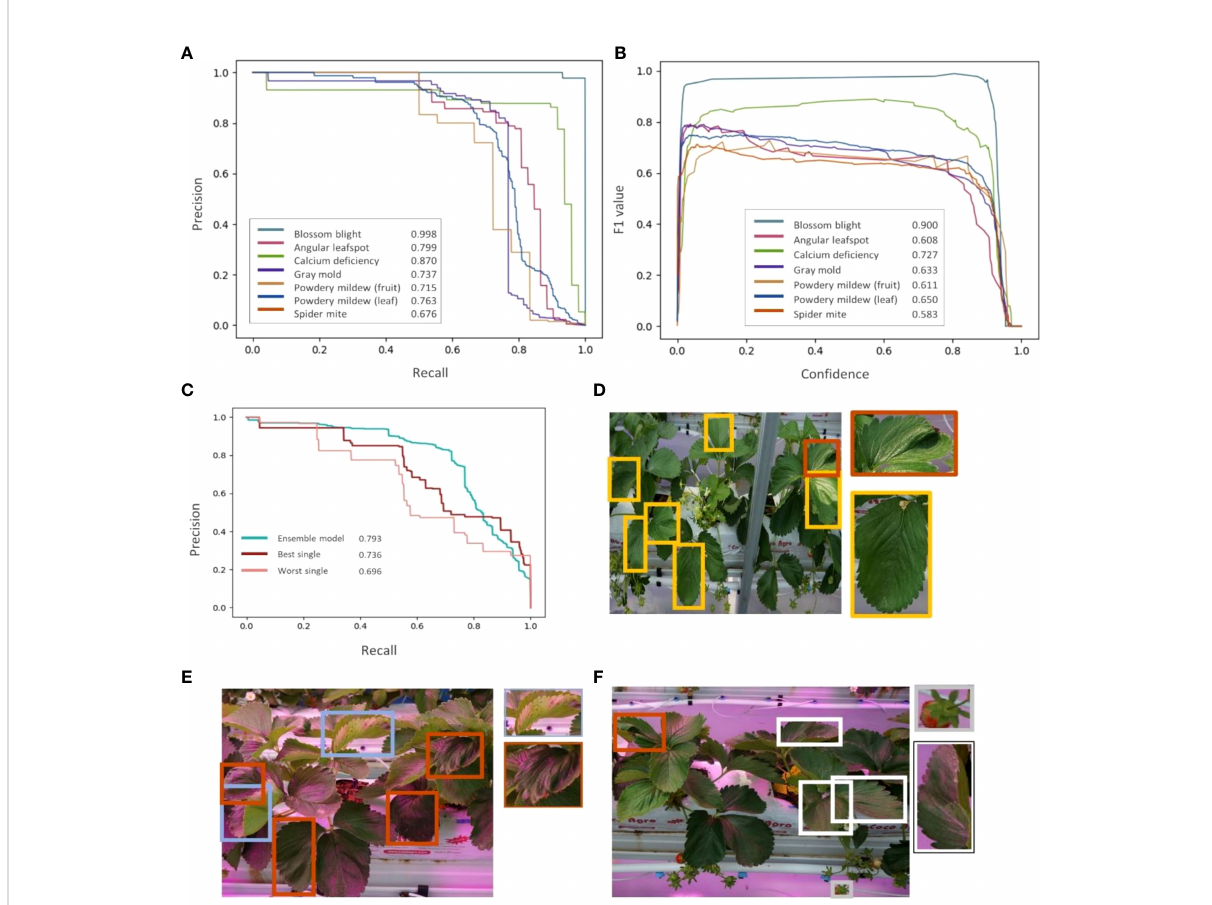
FIGURE 7 Model training results. (A) Precision-Recall curve of seven strawberry diseases and pests. (B) F1-curve of seven strawberry diseases and pests. (C) Comparison of ensemble model and two single models (best and worst). (D – F) An example of detection result of the ensemble model. Orange boxes represent the calcium de fi ciency cases, (D) yellow boxes represent the spider mite cases, (E) skyblue boxes represent angular leafspots, (F) white boxes represent powdery mildew cases, and a gray box represent the gray mold predicted by the